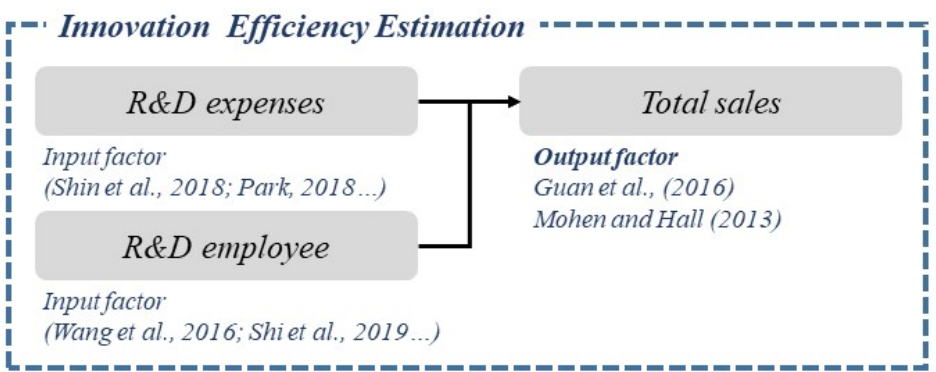
Figure 5. Input and output for efficiency measurement.